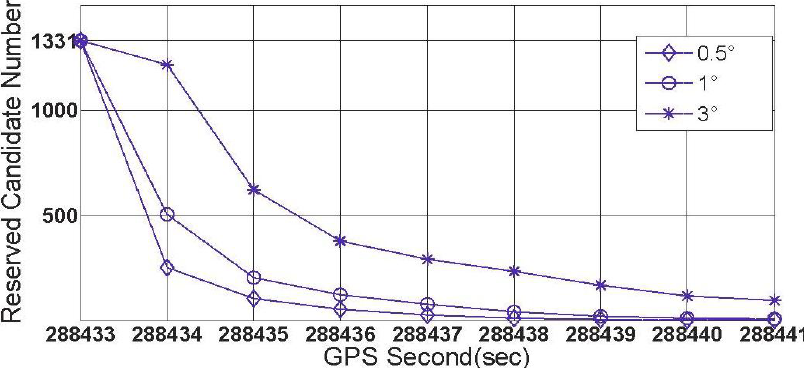
Figure 14. The third group of the results for the feasibility test (data section